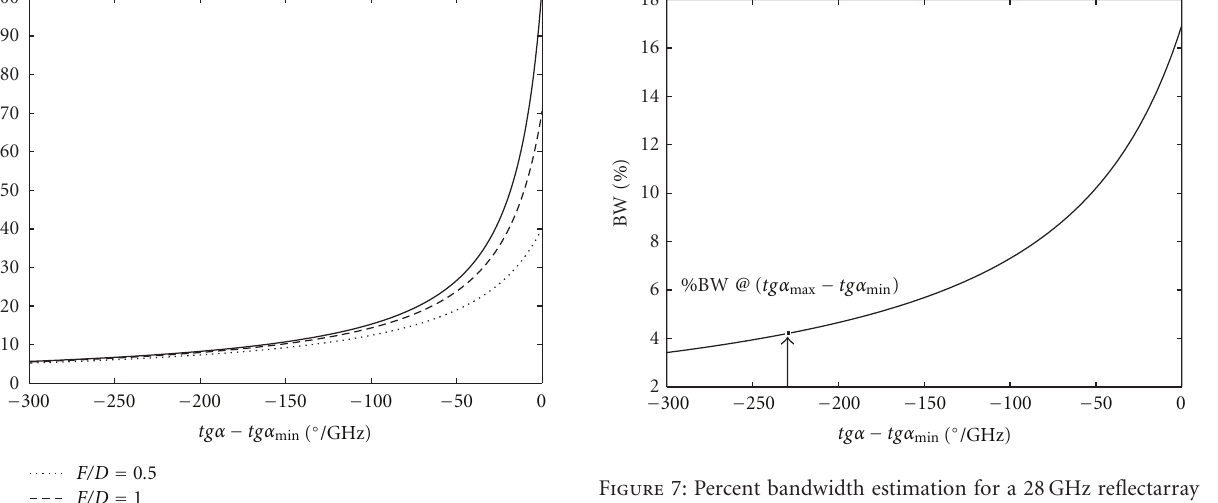
Figure 7: Percent bandwidth estimation for a 28 GHz reflectarray ( D = 21 λ 0 − F/D = 0 . 32) at a fixed phase curve